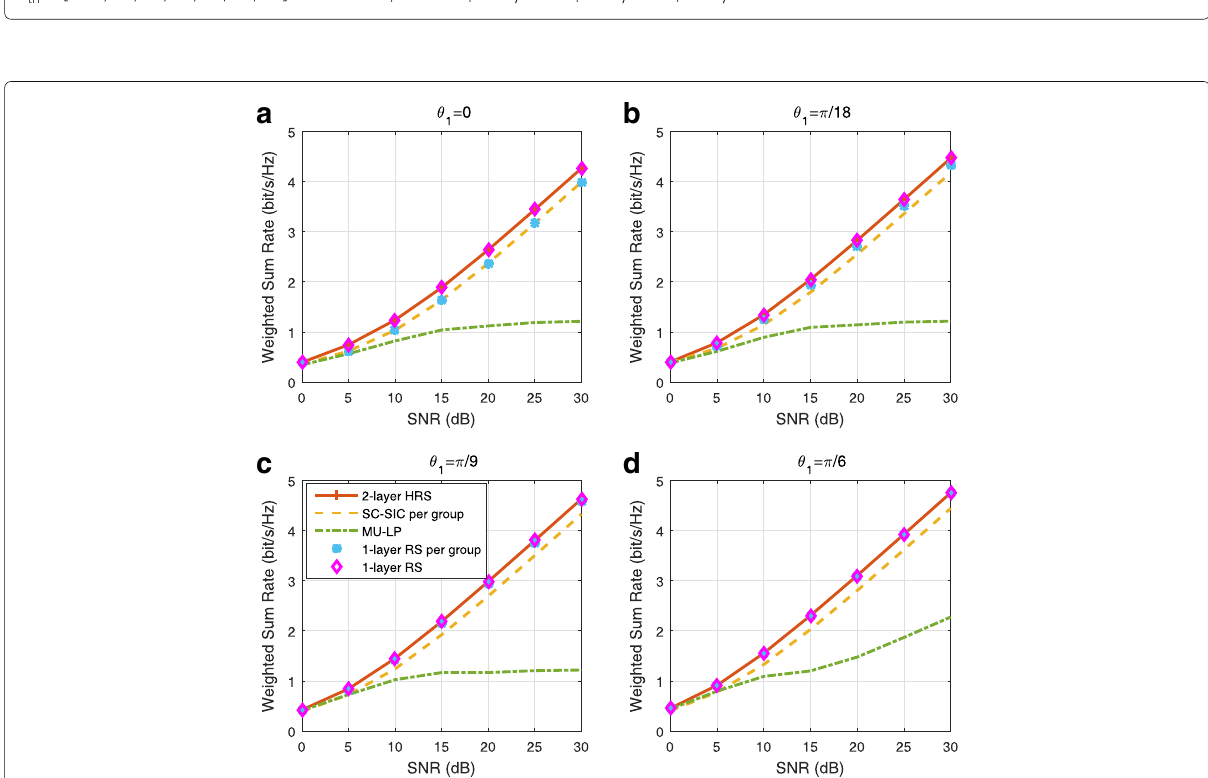
Fig.59 Weightedsumrate versus SNR comparison of different strategies for overloaded four-user deployment with perfect CSIT, γ 1 = 1, θ 2 = θ 1 + π r th = [0.03,0.1,0.2,0.3,0.4,0.4,0.4] bit/s/Hz. a θ 1 = 0. b θ 1 = π/ 18. c θ 1 = π/ 9. d θ 1 = π/